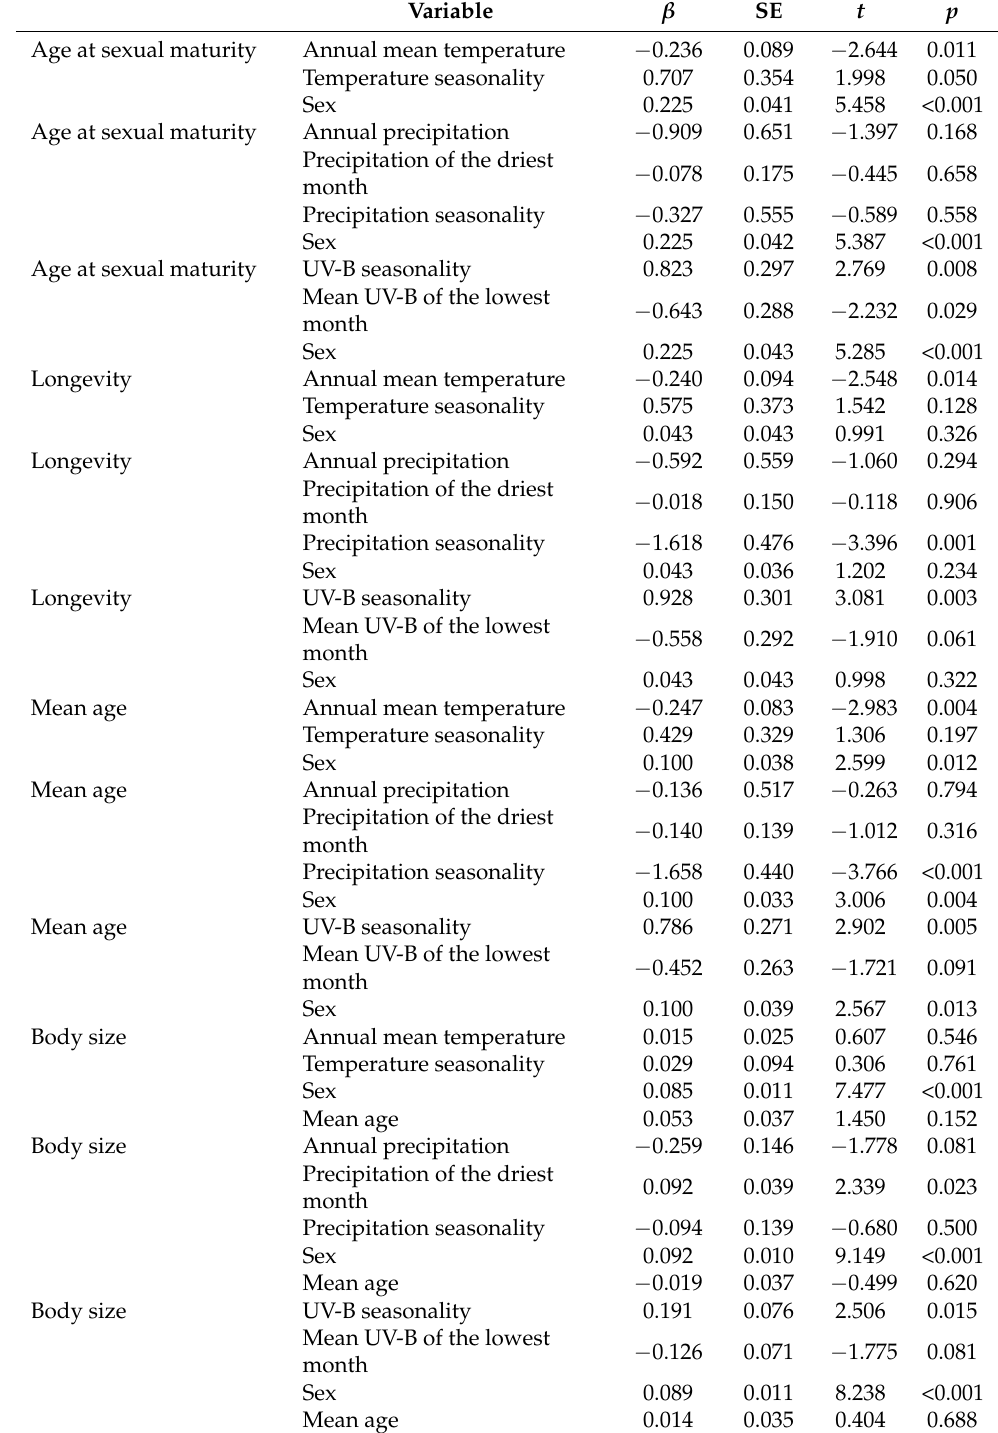
Table 2. The influences of environmental factors on variation in age and body size across 31 popula- tions of Andrew’s toads ( B. andrewsi ) using